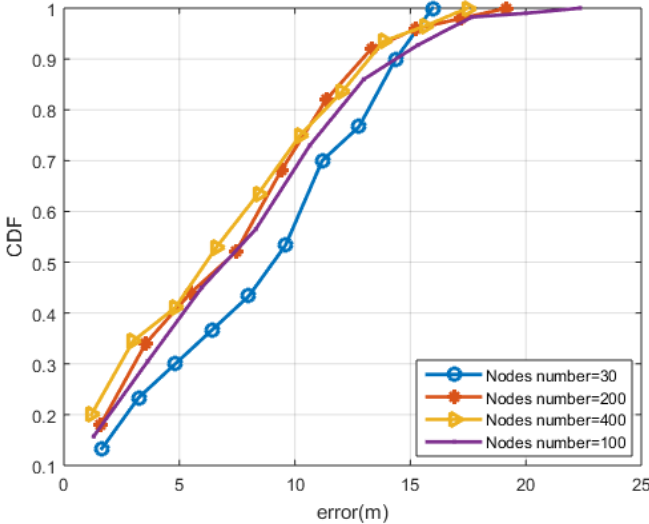
Figure 6. CDFs of KF-BBLA with node number variation.